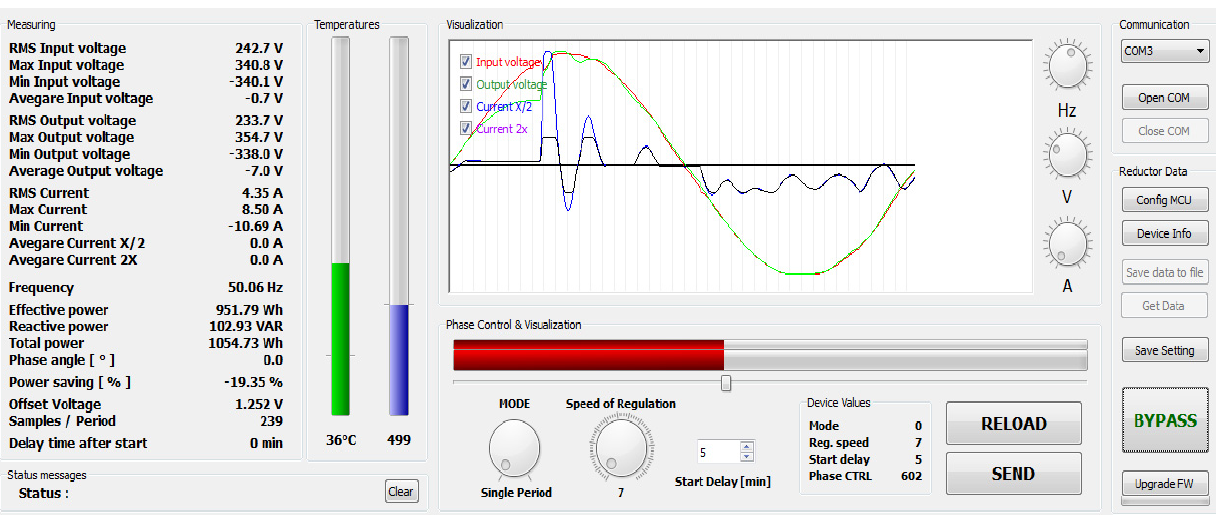
Figure 7. User software data visualization. Input and output sinusoidal voltage and passing current are displayed in the inner